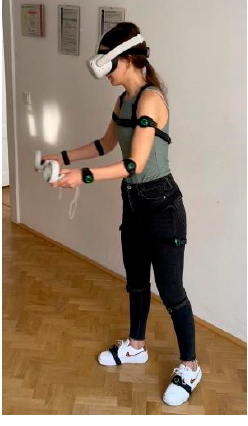
Figure 6. Sample VRb directions.